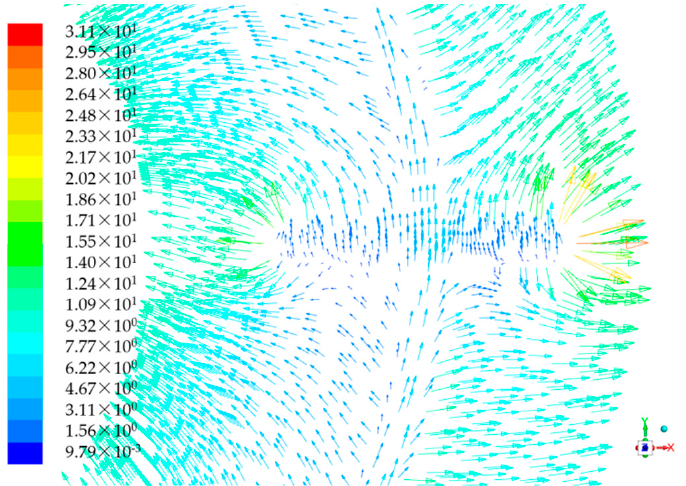
Figure 9. Water velocity distribution on the sliding surface of a star wheel shaft HTB.